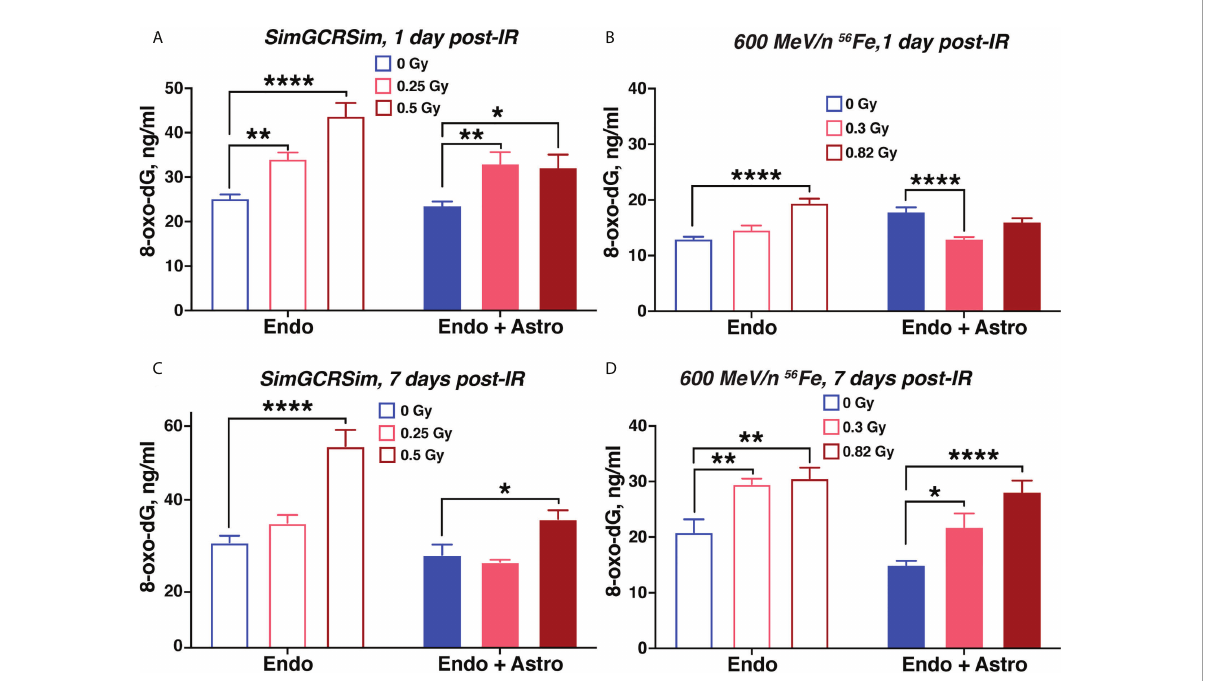
FIGURE 6 Simulated space radiation induces oxidative stress that is partially mitigated by astrocytes. (A – D) Quanti fi cation of secreted 8-oxo-dG in supernatants of chips seeded with endothelial cells only (open bars) and endothelial cells + astrocytes (shaded bars) 1 day (A, B) and 7 days (C, D) after irradiation with SimGCRSim (A, C) or 600 MeV/n 56 Fe (B, D) particles. Blue, 0 Gy sham irradiation. Light red, lower dose (0.3 Gy 600 MeV/n 56 Fe, 0.25 Gy SimGCRSim). Dark red, higher dose (0.82 Gy 600 MeV/n 56 Fe, 0.5 Gy SimGCRSim). N = 12 chips per condition. Error bars, mean ± SEM. *p < 0.05, **p < 0.01, ****p < 0.0001, 2-way ANOVA, Dunnett ’ s multiple comparison ’ s test. Non statistically signi fi cant changes are not